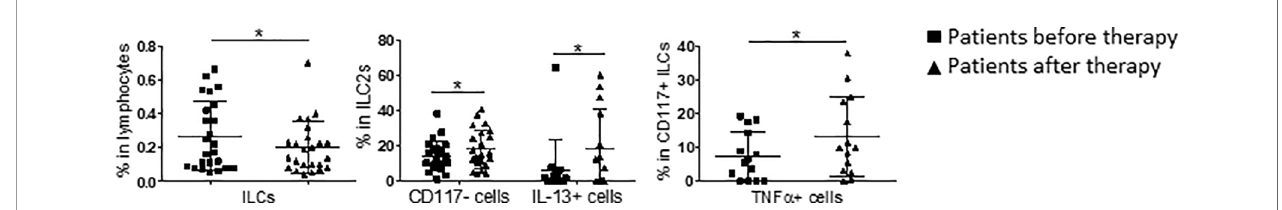
FIGURE 2 | Oscillations in ILC subpopulations induced by Nivolumab treatment in stage IV melanoma patients. Statistical analysis of the frequency of the indicated ILC subsets in stage IV melanoma patients before (squares) and after (triangles) two months of Nivolumab therapy. For total ILCs and CD117 - ILC2s, the analysis was performed cumulating data from 24 patients. For IL-13 and TNF a , the analysis was performed cumulating data from 14 patients. Analyses were performed by paired Student ’ s t-test for normally distributed samples or Wilcoxon matched-pairs signed rank test for not-normally distributed samples. Cumulative data are shown as mean ± SD. *p-value < 0.05. TABLE 1 | Serum cytokines/chemokines deviating from physiological range in Nivolumab-treated stage IV melanoma patients. Cytokine Physiological Mean ± SD before Mean ± SD after p- range (pg/ml) treatment (pg/ml) treatment(pg/ml) value